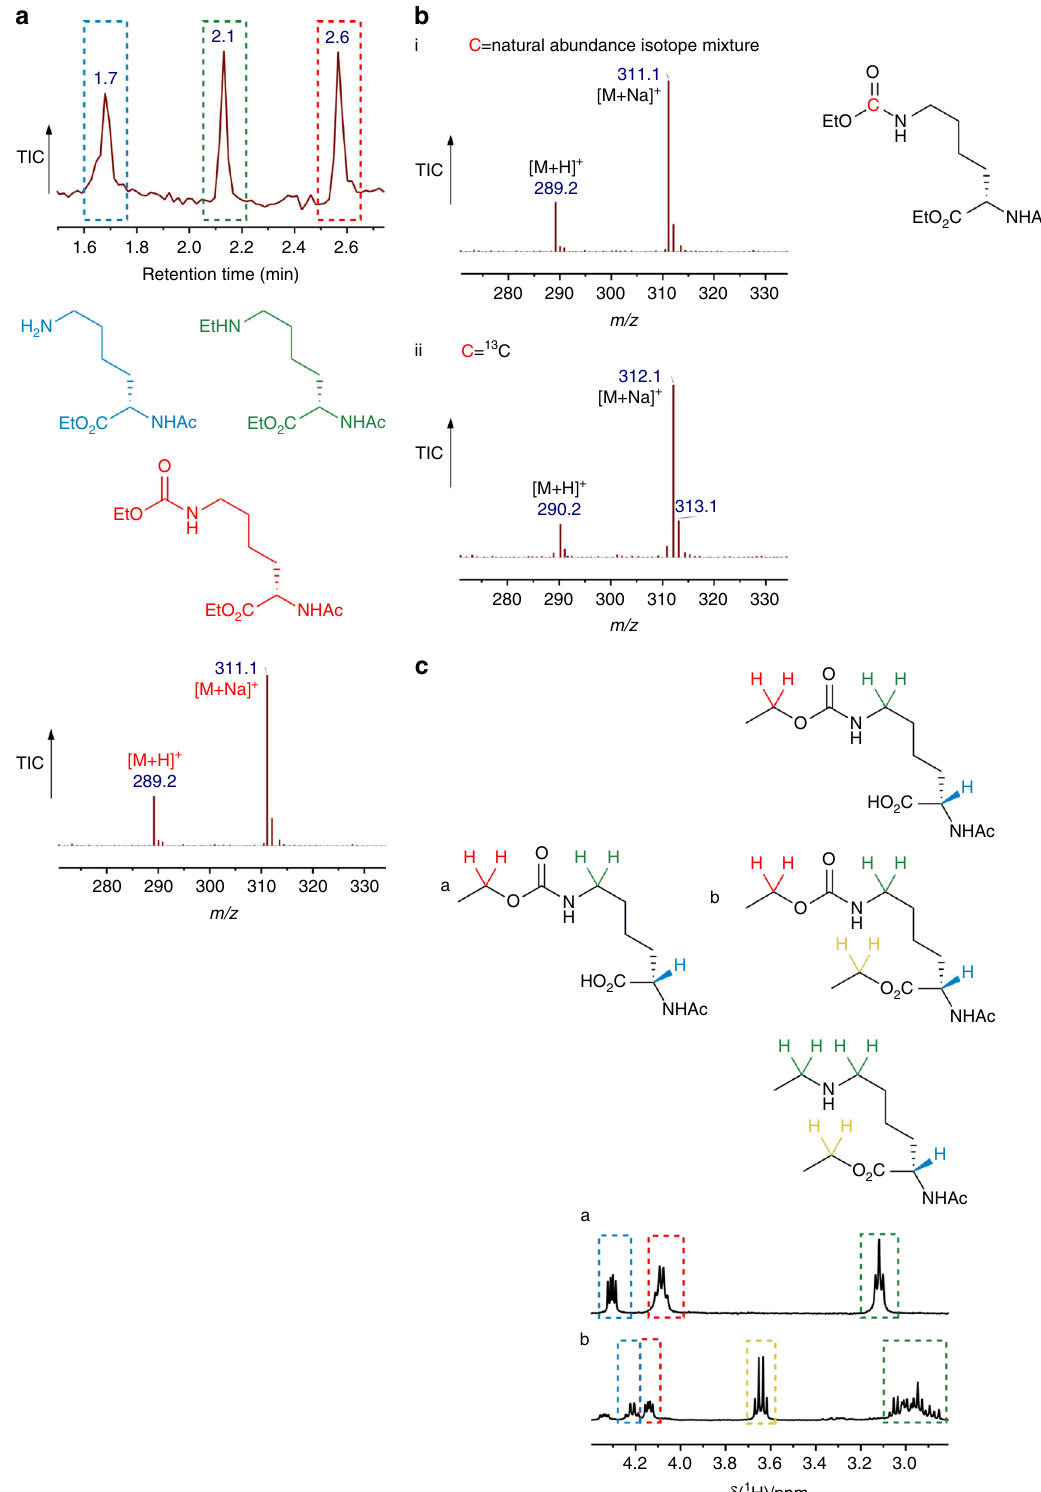
Fig. 3 Characterisation of carbamate trapping on the ε -NH 2 group of α - N -acetyl-lysine. a Total ion chromatogram of the carbamate-trapping reaction mixture of α - N -acetyl-lysine with TEO, and m/z pro fi le for species at retention time ~2.6 min. The major products of the trapping reaction are N -acetyl- lysine ethylated on the α -carboxylate group (retention time ~1.7 min), α - N -acetyl-lysine ethylated on the α -carboxylate and ε -NH 2 groups (retention time ~2.1 min) and α - N -acetyl-lysine ethylated on the ε -carbamate and the α -carboxylate groups (retention time ~2.6 min). b MS trace demonstrating the increase of one mass unit from 12 C (i) with the use of 13 C labelled CO 2 (ii). c . 1 H-NMR spectra comparing ethyloxycarbonyl signals between a chemically synthesised α - N -acetyl- ε - N -ethyloxycarbonyl-lysine and b ethylation products formed during the trapping experiments between α - N -acetyl-lysine, CO 2 and TEO (key CH 2 signals highlighted in